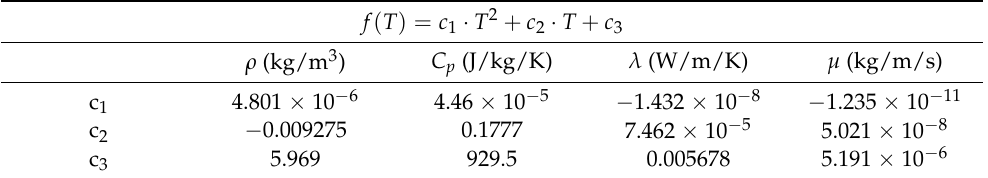
Figure 3. Computational domain and parameters of simplified the DF-PCHE entrance head and channels, ( a ) schematic of the DF-PCHE entrance head and channels, ( b ) computational domain and boundary conditions of entrance head, ( c ) computational domain and boundary conditions of simplified DF-PCHE channels, and ( d ) structures and parameters of SPBs of 3 × 3, 4 × 4, and 5 × 5. Table 1. Thermo-physical properties of air for the micro gas turbine (600–720